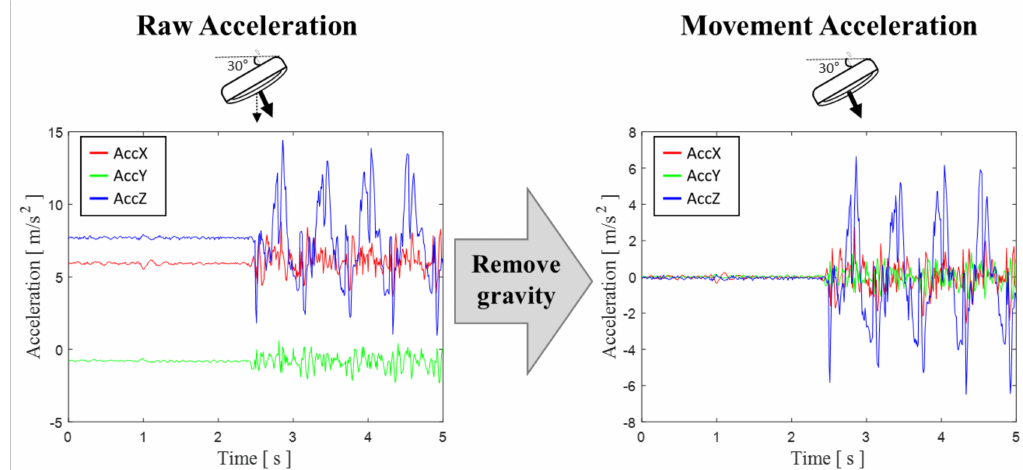
Figure 3. Removing the gravity component from the acceleration